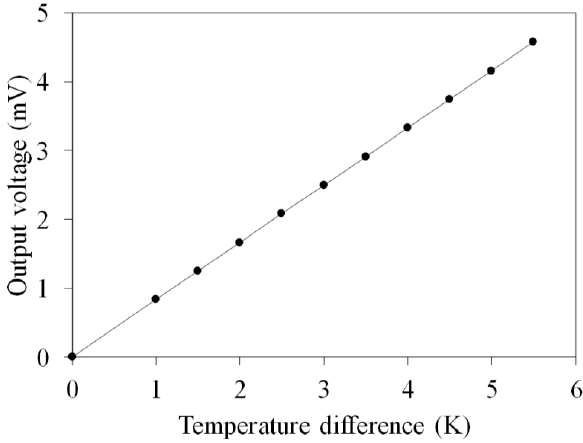
Figure 2. Simulated output voltage for the flexible thermoelectric generator.